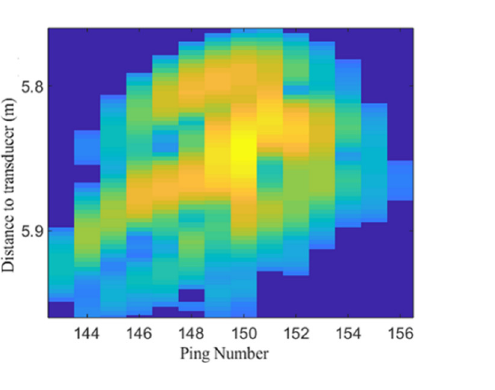
Figure 4. Identification of acoustic traces in the echogram within windows of time and space.